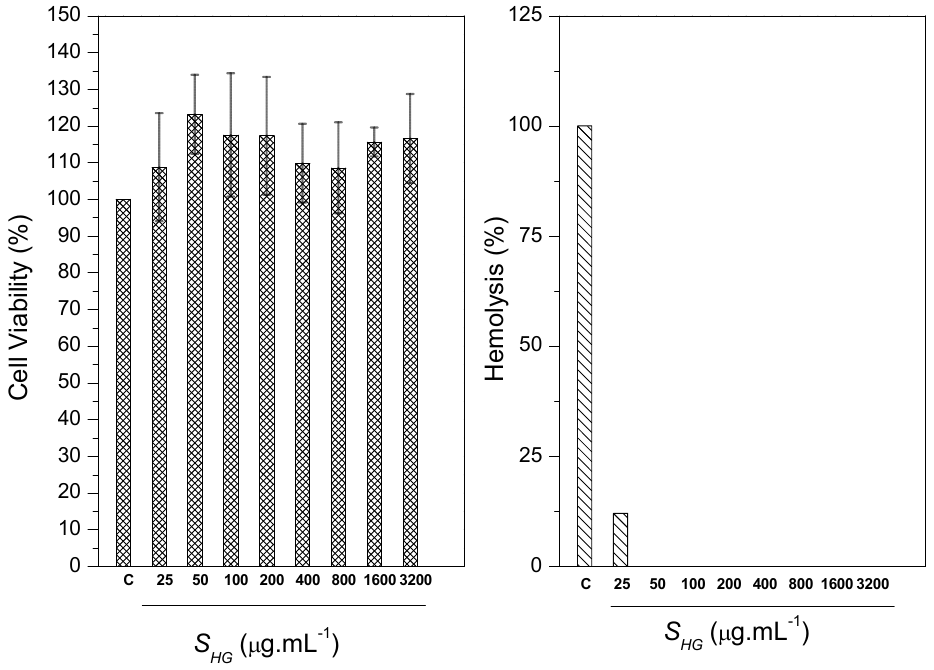
Figure 15. MTT assay and hemolytic activity for S HG scaffolds.